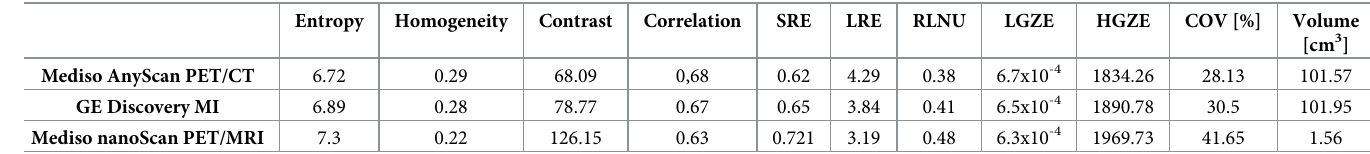
Table 5. The values of the heterogeneity parameters of the same pattern measured in three PET scanners after the harmonization of voxel